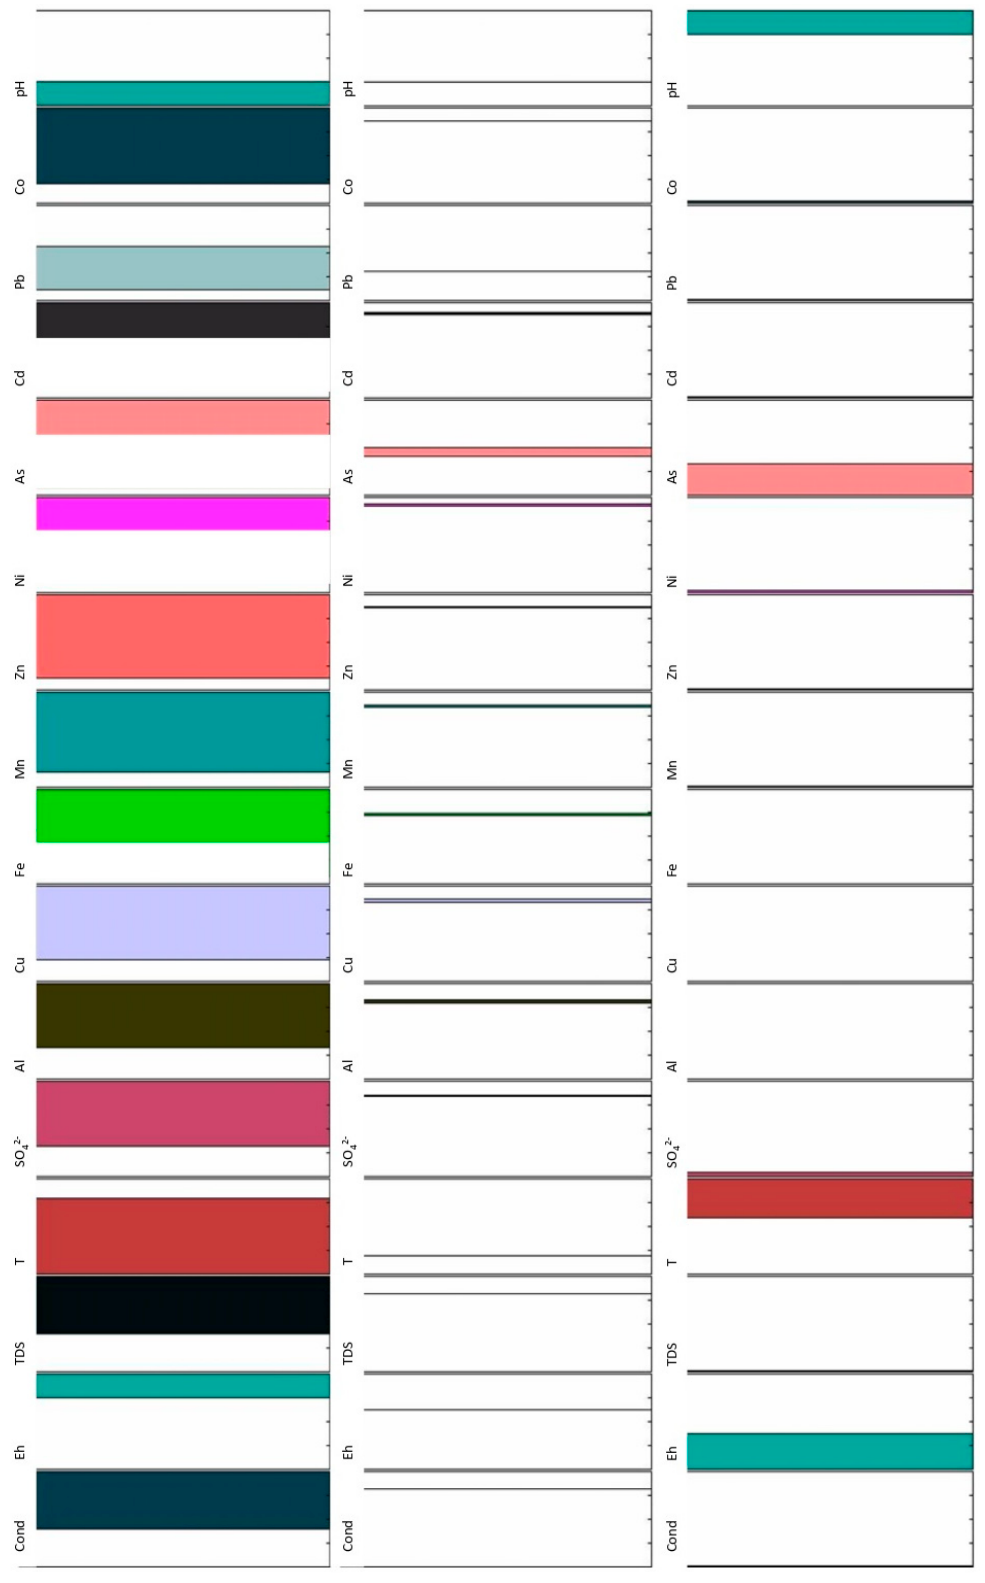
Figure 8. Fuzzy rules taking pH as a consequence.